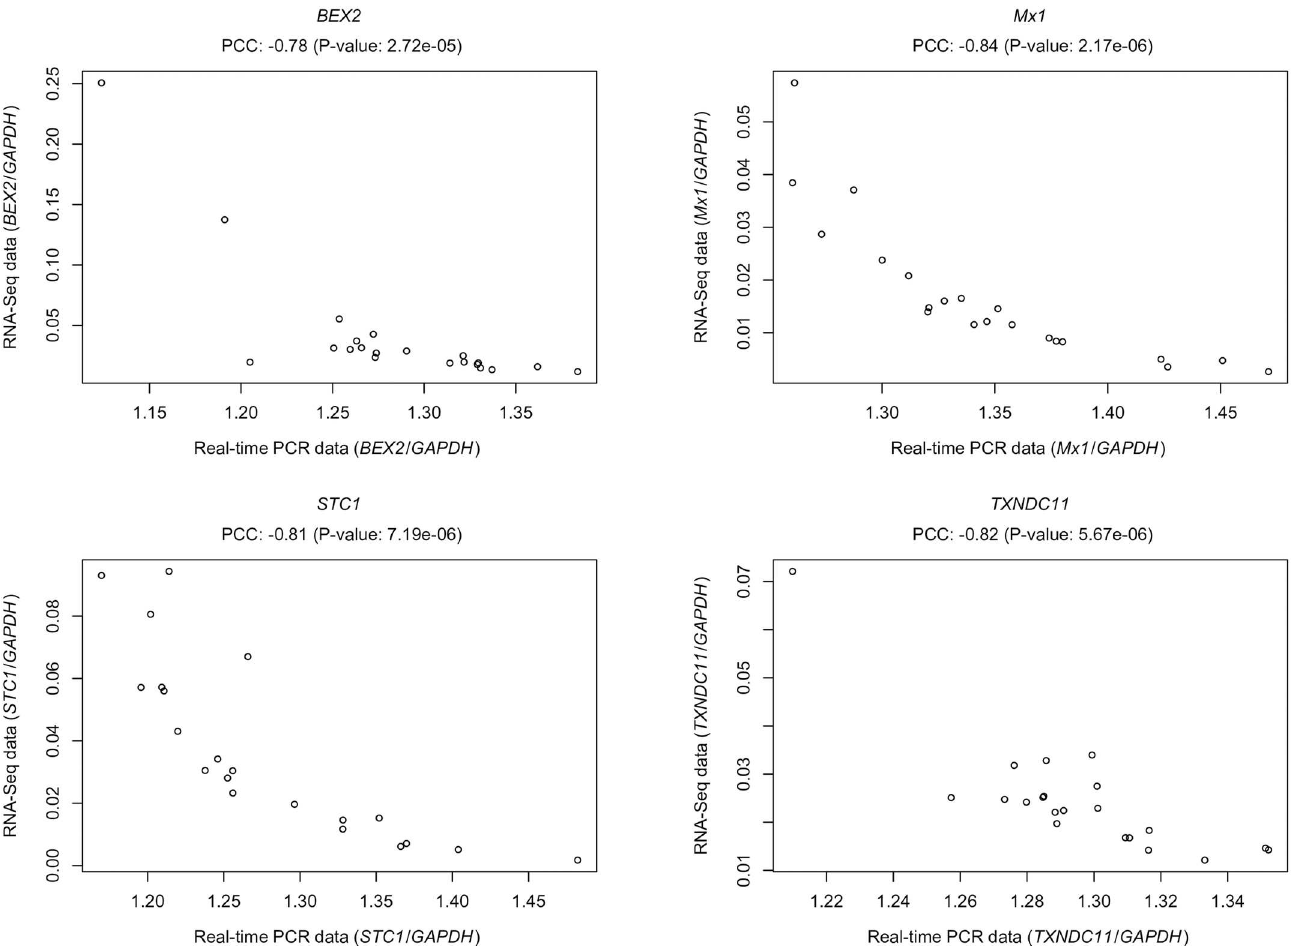
Fig 5. Scatter plots of the Real-time PCR data vs. RNA-Seq counts for the genes tested and Pearson Correlation Coefficient (PCC). The horizontalaxis represents the ratio between the averageCp of the target gene and the averageCp of the reference ( GAPDH ) for all the samples. The vertical axis is the ratio betweenthe RNA-Seqcounts of the target gene and the reference gene for all the samples. PCC is the Pearson Correlation Coefficientbetweenthe Real time PCR data and the RNA-Seqdata.